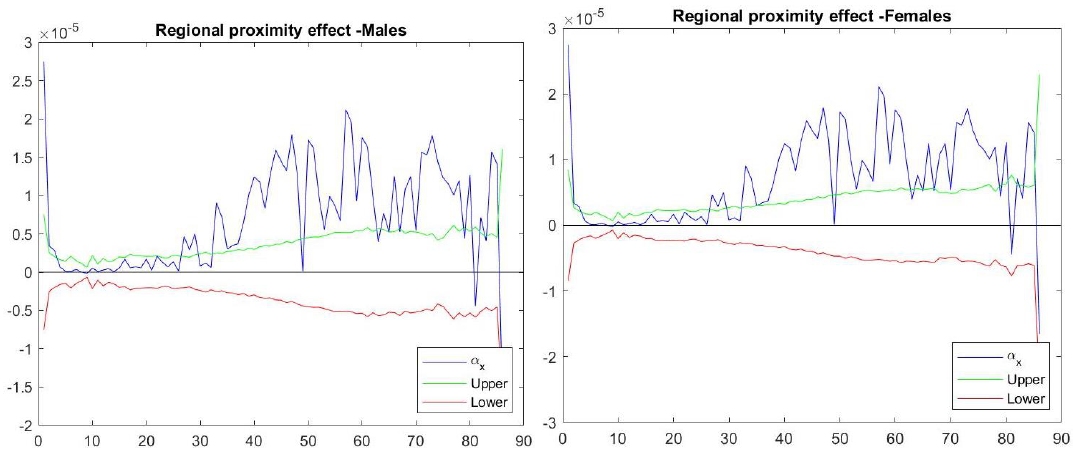
Figure 5. Bounds for regional mortality